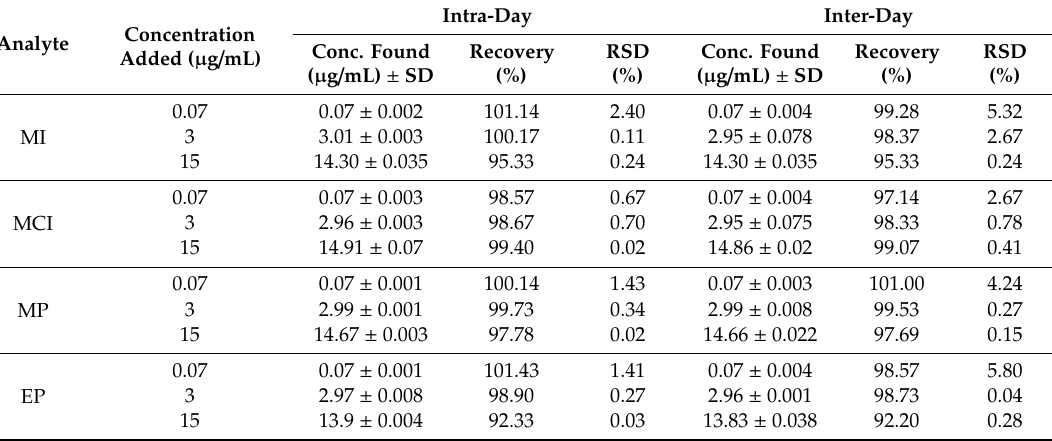
Table 2. Accuracy and precision of the proposed (UHPLC / DAD)